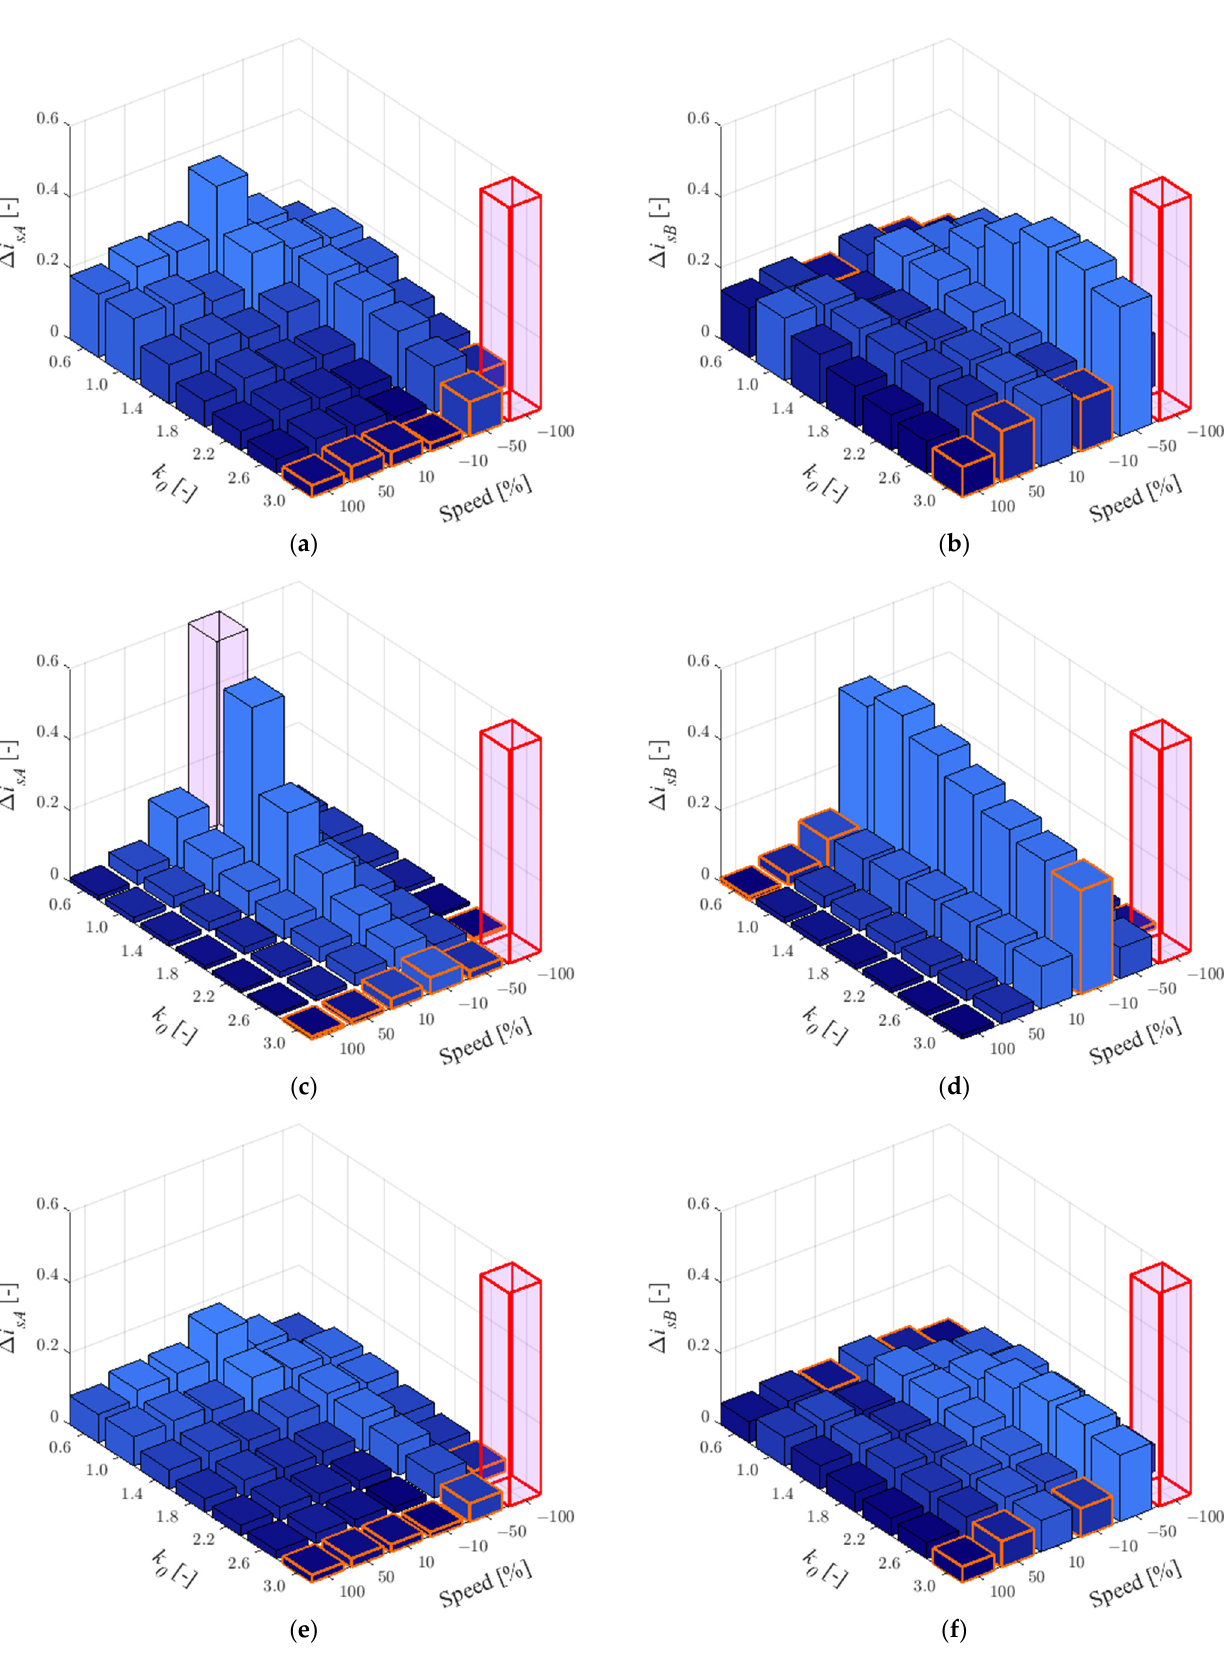
Figure 6. RMSE values for stator currents in phase A ( a , c , e ) and B ( b , d , f ) for r rIM = 1.5 r